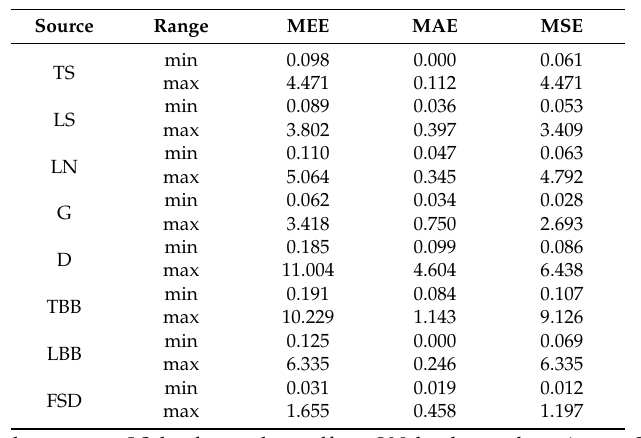
Table 2. Ranges of MEE, MAE, and MSE for each source in the GSD range of 1.5–2.5 and the d g range of 0.1–2.5 µ